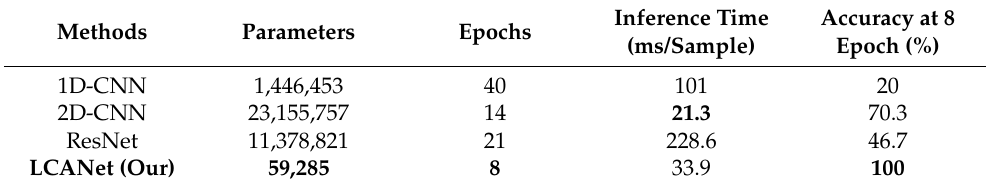
Table 1. Computational Complexity Comparison of Different SHM